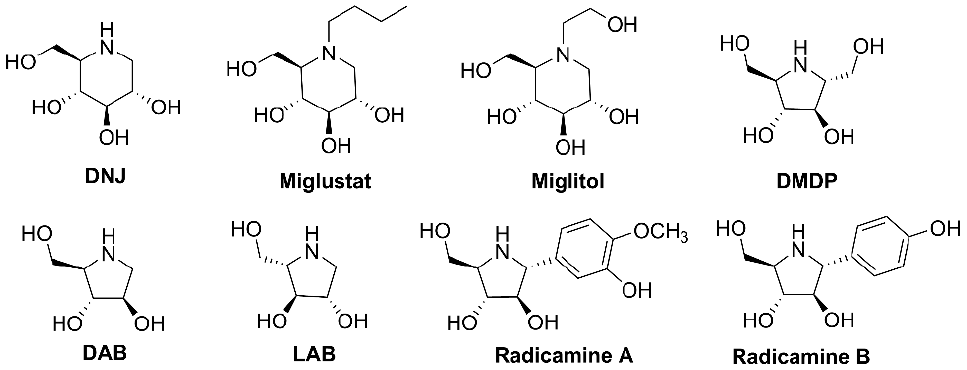
Figure 1 . Examples of natural and synthetic iminosugars. Figure 1. Examples of natural and synthetic